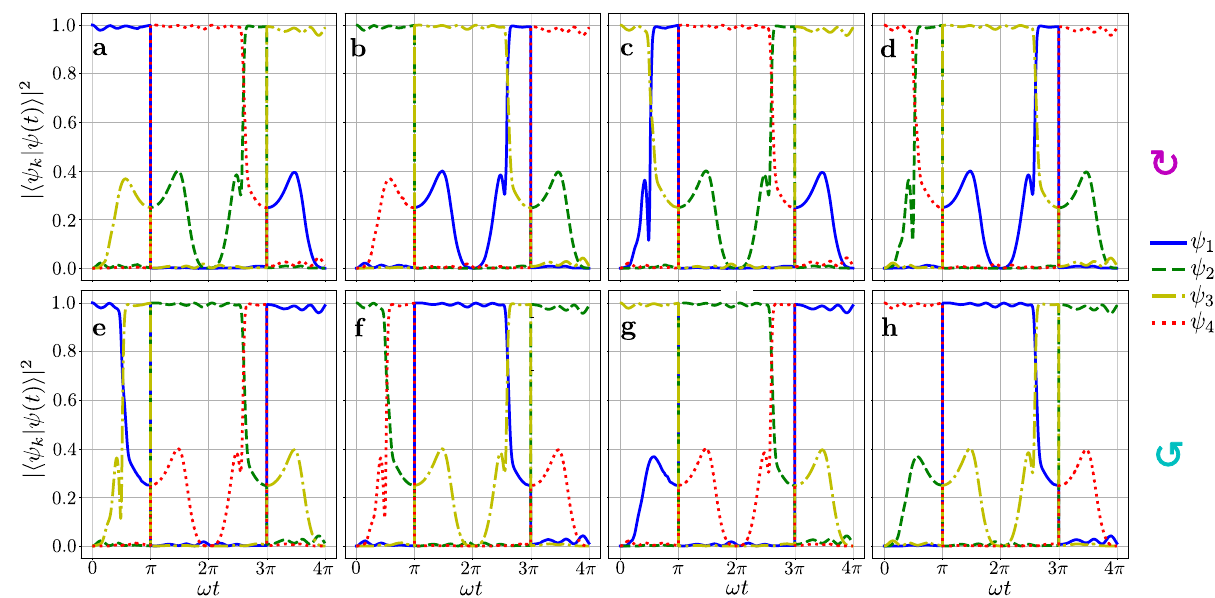
Fig. 4 | Fidelity ∣ 〈 ψ k ∣ ψ ( t ) 〉 ∣ 2 of the NHH eigenstate ψ k at time t and the time- evolving state ψ ( t ) during a double period 2 T . The initial eigenmodes ψ … ,4, arelocated in theexact PT -phase (see also Fig.3 b ).Clockwise (panels k , k =1, a – d ) and counterclockwise (panels e – h ) encircling directions. Depending on the winding direction and the number of times the loop encircles the exceptional curve, EC, with the diabolic curve, DC, crossing, one can realize various mode- switching combinations. Mode-switching combinations, illustrated here, are